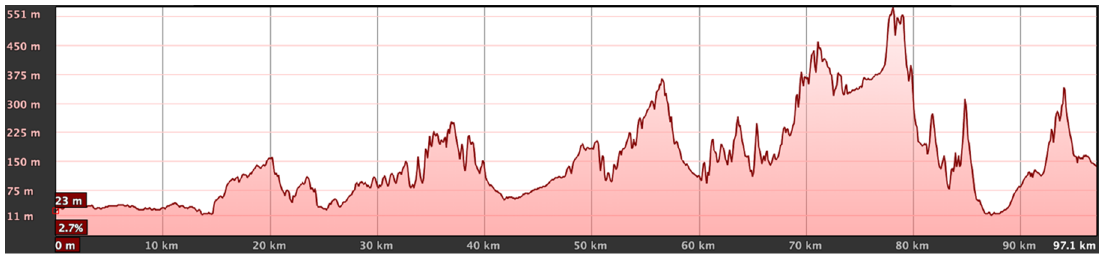
Figure 8. Elevation profile of the NVIS link.